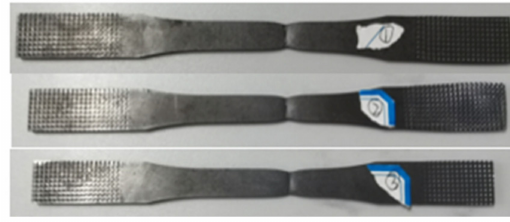
Figure 9. Tensile fracture diagram of